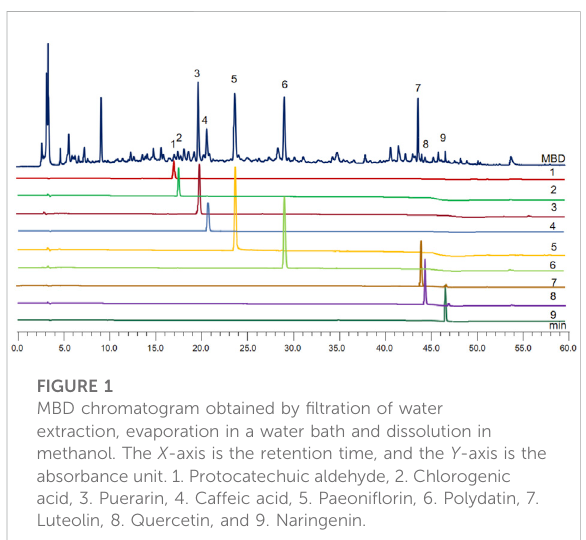
FIGURE 1 MBD chromatogram obtained by fi ltration of water extraction, evaporation in a water bath and dissolution in methanol. The X -axis is the retention time, and the Y -axis is the absorbance unit. 1. Protocatechuic aldehyde, 2. Chlorogenic acid, 3. Puerarin, 4. Caffeic acid, 5. Paeoni fl orin, 6. Polydatin, 7. Luteolin, 8. Quercetin, and 9.